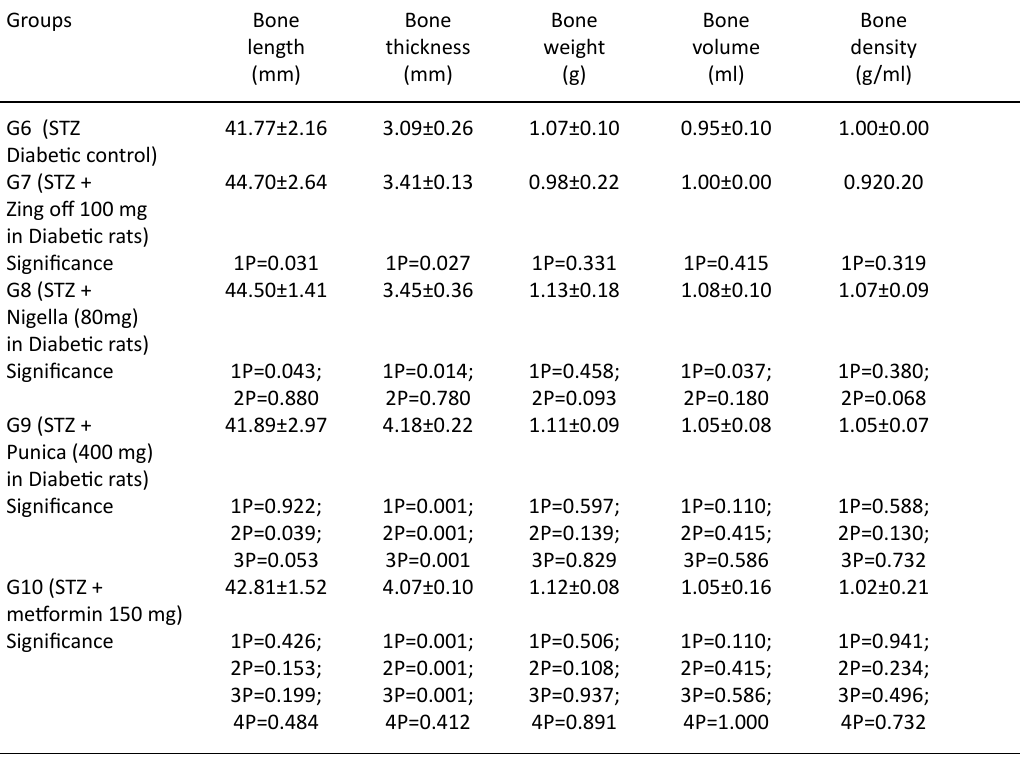
Table 1. Comparison of the Bone Parameters in different studied groups at different days.